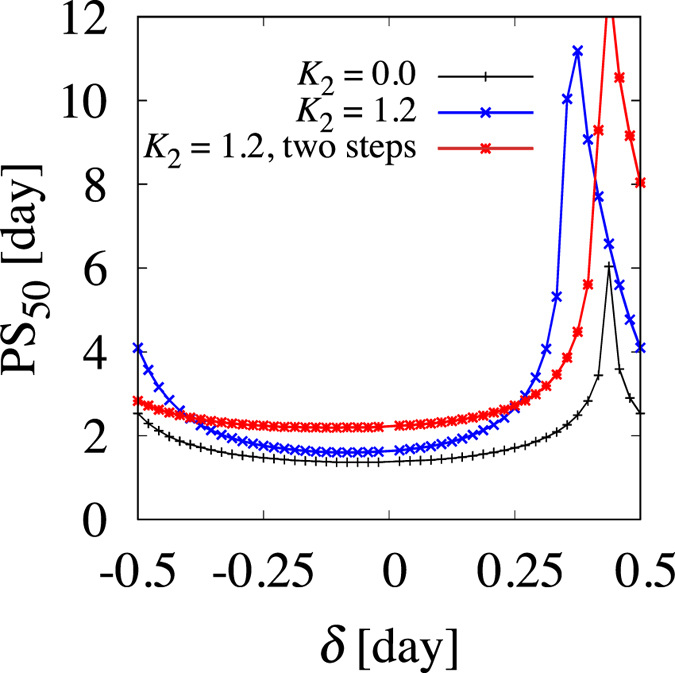
Adaptation time (PS50) vs various values of jet lag δ.PS50 is defined by the 50% phase-shift value of ψ( = ψ1,2) for K2 = 0.0 and Ψ for K2 = 1.2.